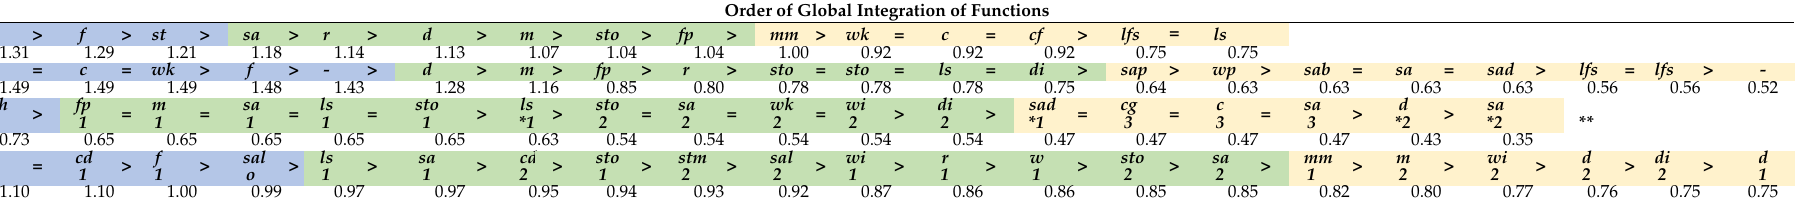
Table 2. Order of global integration of functions from axial line analysis.